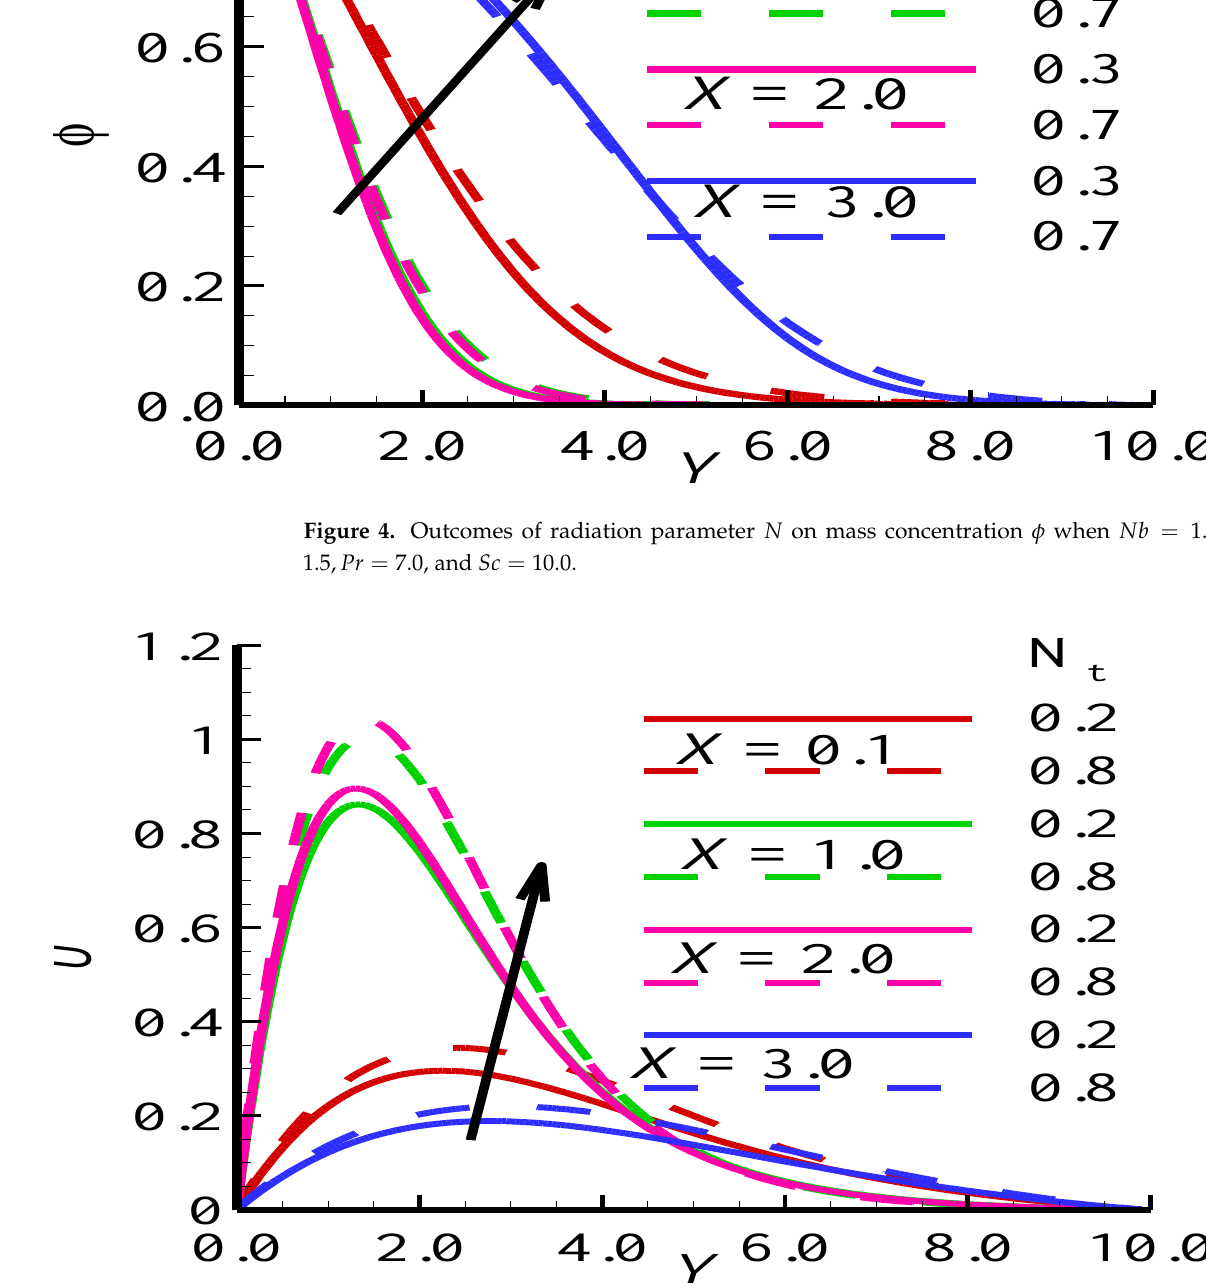
Figure 5. Outcomes of thermophoresis parameter N t on velocity distribution U when N = 0.5, Nb = 1.5, Pr = 7.0, and Sc = 10.0.